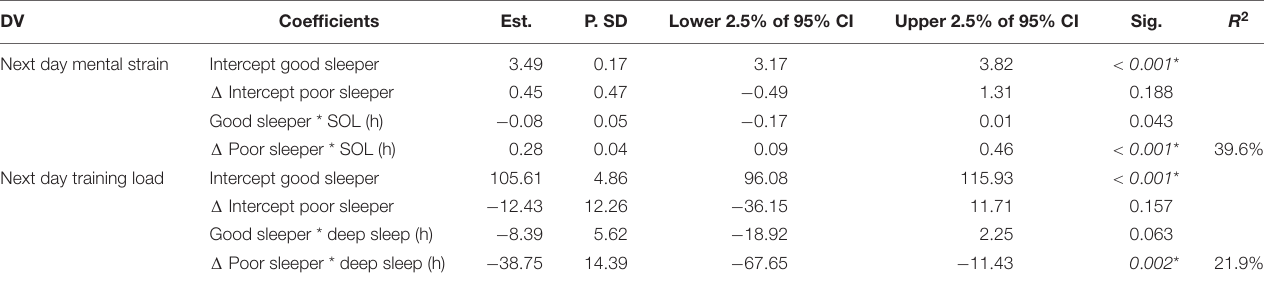
TABLE 6 | Cross-interaction analyses investigating the moderating effects of subjective sleep quality on the effect of explanatory variables on dependent variables (see Figure 3 for overview of tested associations). DV Coefficients Est. P. SD Lower 2.5% of 95% CI Upper 2.5% of 95% CI Sig. R 2 Next day mental strain Intercept good sleeper